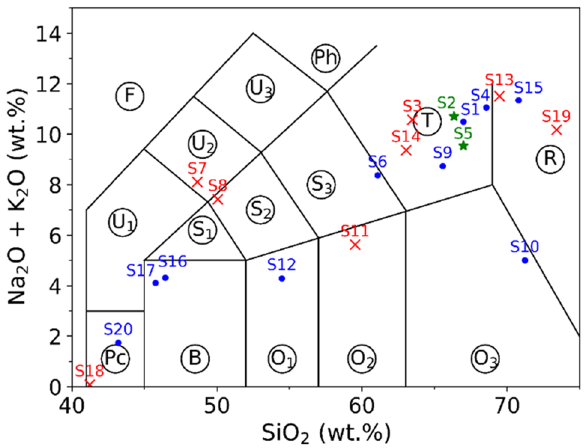
Figure 1. Presentation of the used rock samples in a TAS diagram according to their major oxide concentrations determined using XRF. The short notations of the 15 fields (surrounded by circle) are according to Reference 22 . The green stars represent the 2 isolated samples for model validation; the blue dots represent the 10 additional validation samples for the transfer learning models, and the red crosses represent the 8 training rock samples for the transfer learning models.